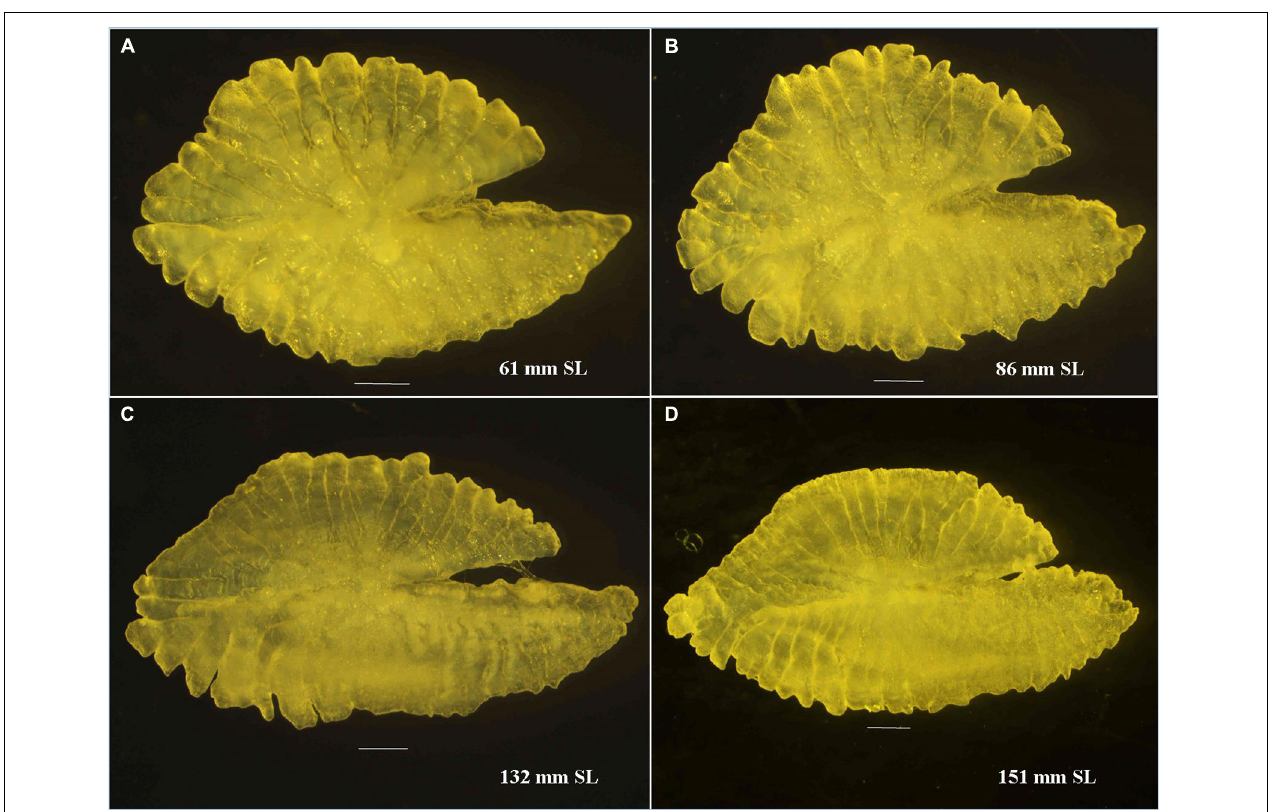
FIGURE 4 | Pampus griseus . (A,B) Sagittal otolith of juvenile and (C,D) adult specimens.